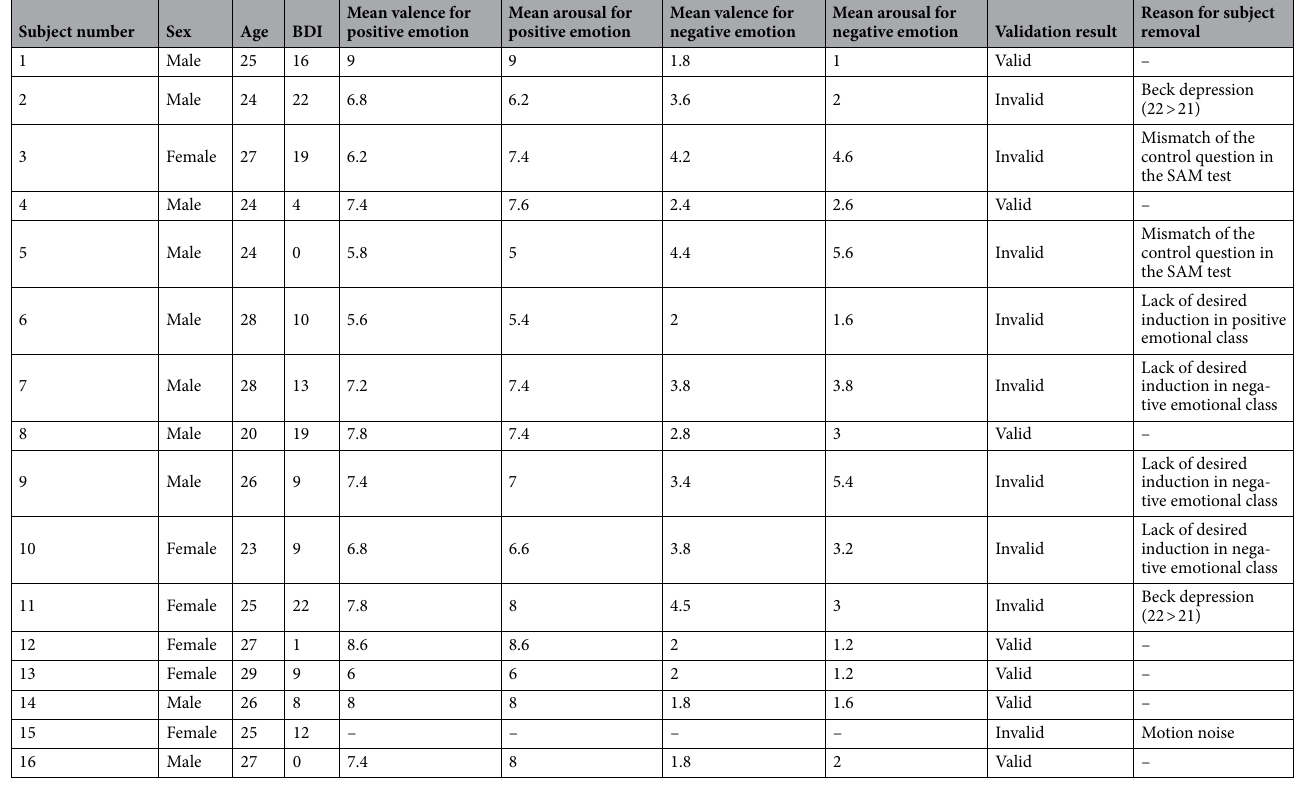
Table 1. Validation of individuals participating in the EEG signal recording process in order to identify positive and negative emotions 43 .